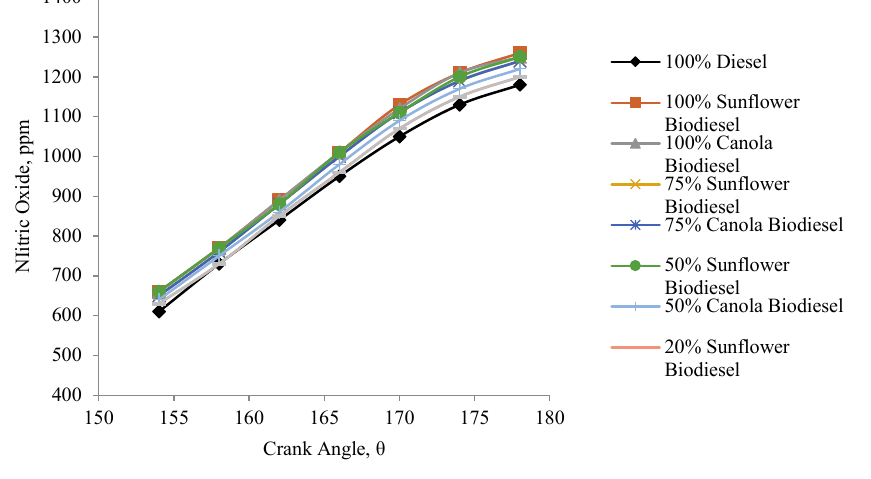
Fig. 12. Nitric oxide emission against crank angle at1500 rpm.